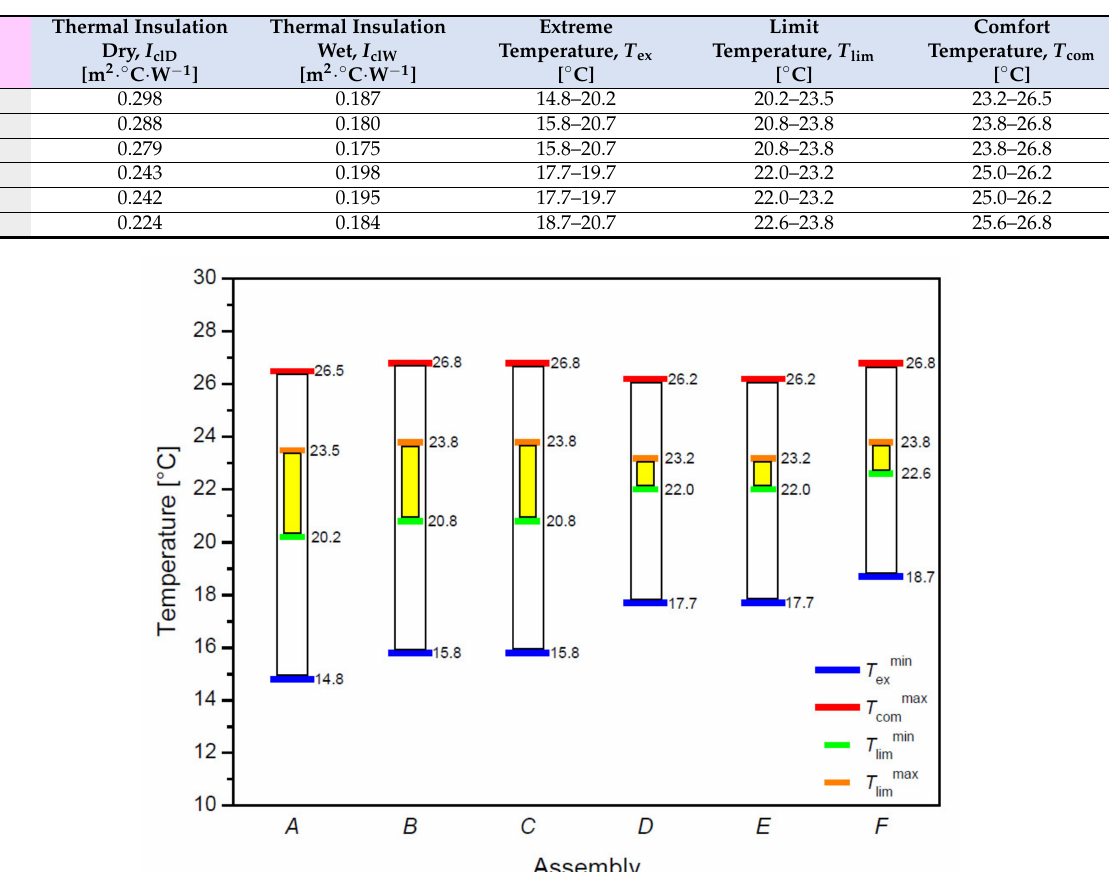
Figure 12. The sleeping bag’s comfort, limit, and extreme temperatures ( T com , T lim , T ex ) were determined on the basis of the thermal resistance men posture, according to the physiological model